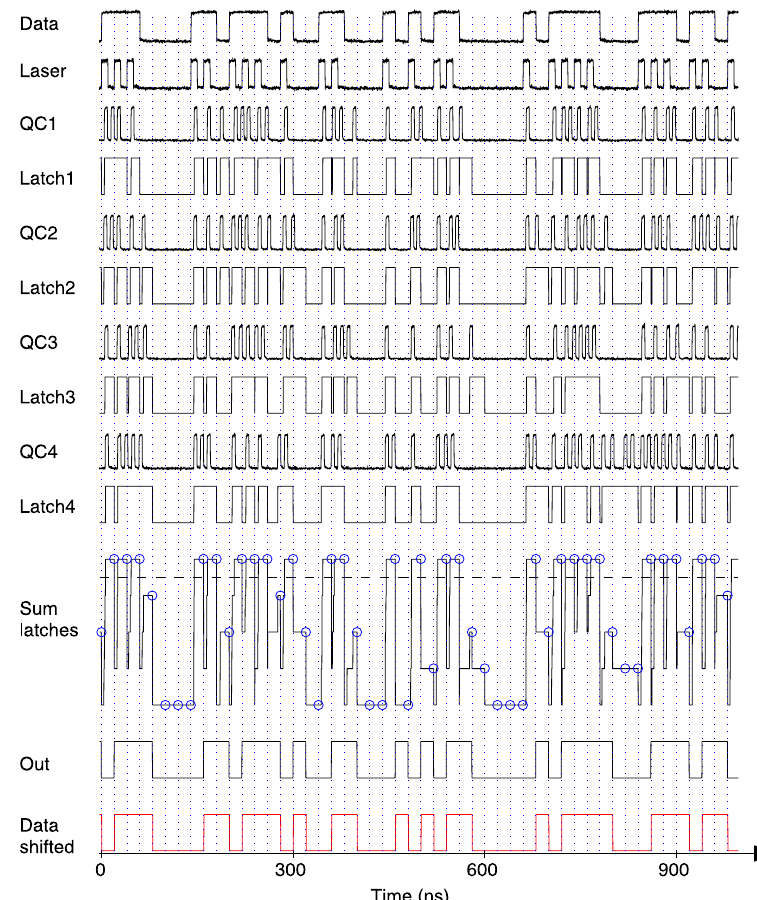
Figure 7. Digital latch-type processing of the 4 quencher circuits (QC) output data for 50 Mbit/s RZ at an optical power of 7.5 nW. The signals for a sequence of 50 bits were exported from Matlab. The PRBS7 “Data” signal was measured at the output of the bit pattern generator and read into Matlab. For the measurement of the “Laser” signal the duty cycle in the bit pattern generator was set to 50% to obtain RZ instead of NRZ. “Data” and “Laser” signals were measured once before the experiments (this was sufficient since PRBS7 repeats after 127 bits). The signals QC1, QC2, QC3 and QC4 are simultaneously measured QC output signals. The “Latch1” to “Latch4” curves are calculated by MATLAB. The “Sum latches” is calculated by MATLAB as the sum of the 4 latch signals. The dashed line represents the decision threshold used by MATLAB in order to determine at the end of each bit whether a “1” or “0” was detected. The blue circles represent the values taken for the decisions. The final output data “Out” are therefore shifted by one bit period to the right compared to the input data “Data”. For easy comparison, the input data “Data” are shifted by one bit to the right and are added as “Data shifted” at the bottom of the figure (red